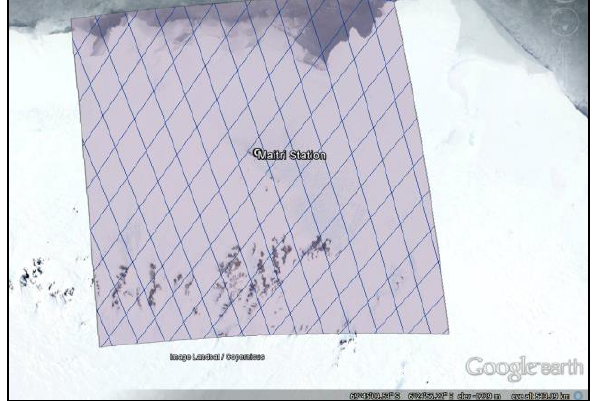
Figure 2. Region of Antartica used for Saral data processing and ice sheet elavation, velocity study and ground